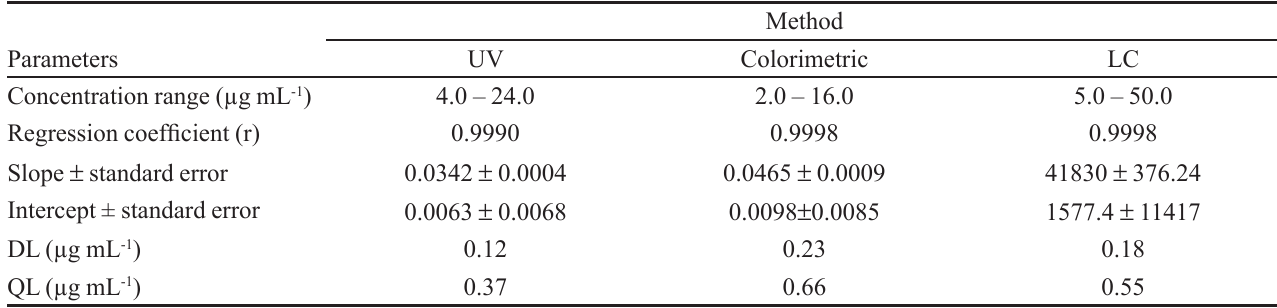
TABLE I - Overview of the linearity, detection limit (DL) and quantitation limit (QL) data obtained for deflazacort by the